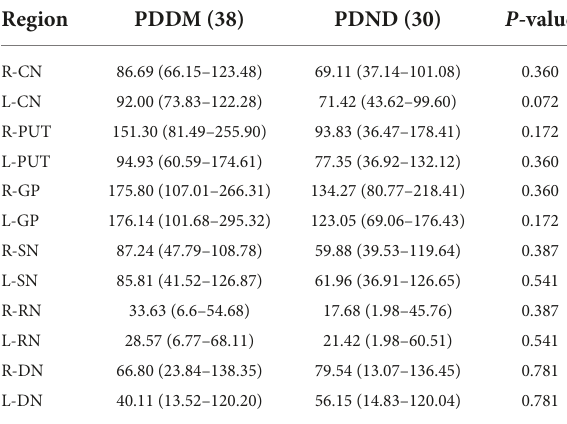
TABLE 6 V RII of gray matter nucleus between PDDM group and PDND group.